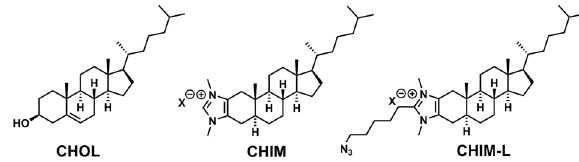
Fig 1 Imidazolium-based cholesterol analogs CHIM and CHIM-L. Molecular structures of natural cholesterol (CHOL) and the herein characterized CHIM analogs (X = Cl,